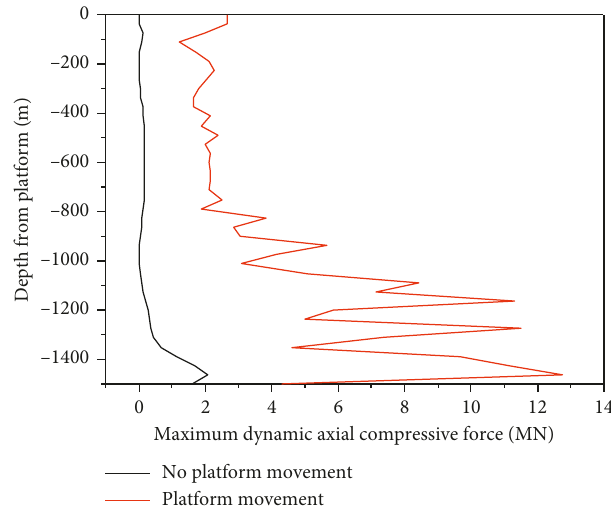
Figure 18: Effect of platform motion on maximum dynamic axial compressive